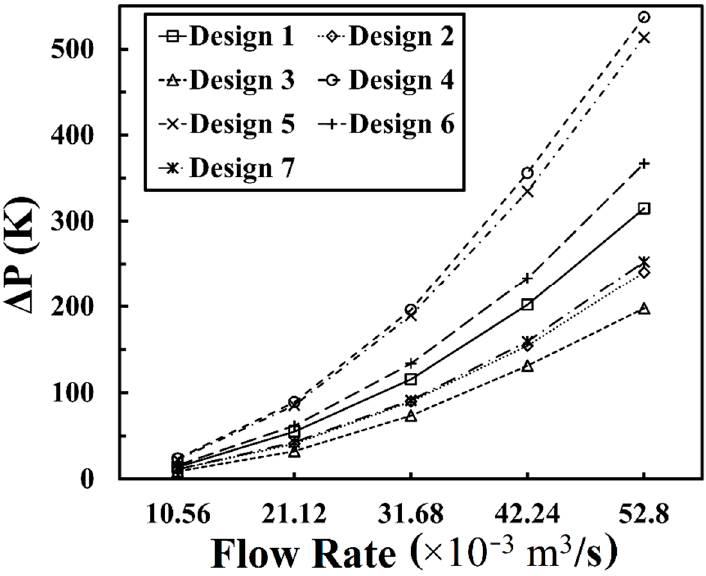
Figure 10. Pressure differences of 7 designs at 5 flow rates.